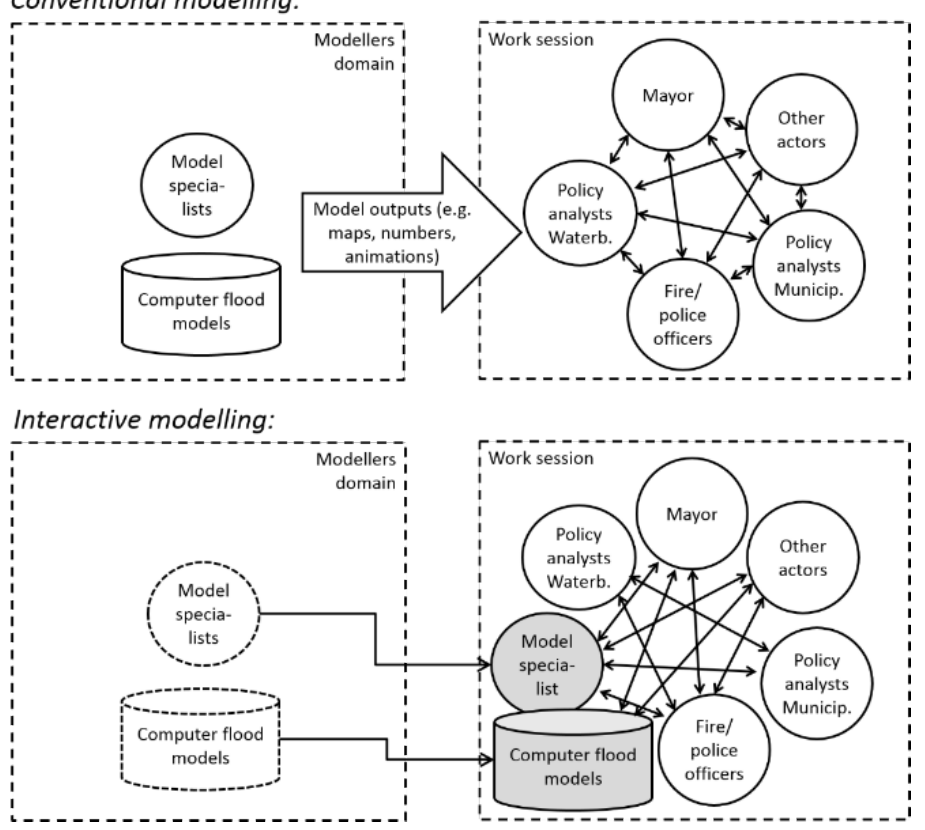
Figure 2. The conventional use of model outputs ( top ) versus the application of an interactive model ( bottom ). In the situation of conventional modelling, a model is used to prepare static outputs for work sessions of practitioners. In the case of interactive modelling, a model is used during work sessions of practitioners to provide outputs on demand.